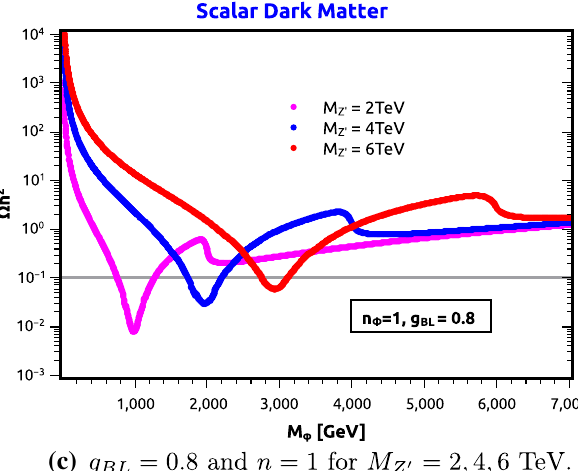
Fig. 4 Scalar field. Abundance as a function of mass. The kinks in the plots are the result of the Z (cid:2) threshold, i.e. when the scalar can pair annihilate to produce Z (cid:2) bosons